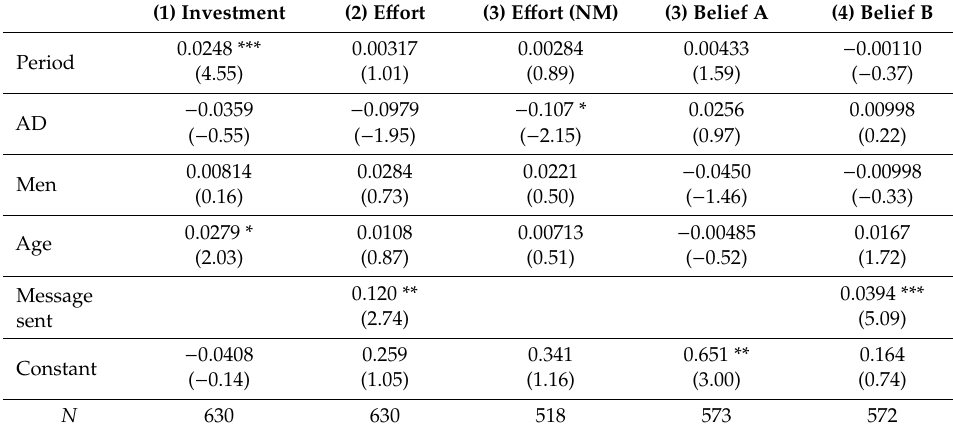
Table A3. Random GLS models for AD decisions.